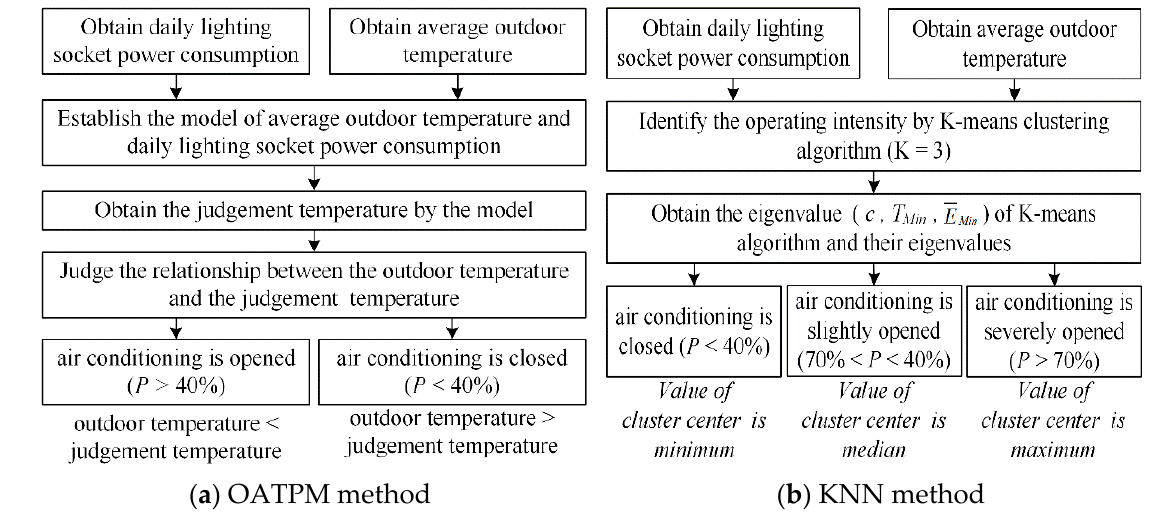
Figure 12. Identification method of air-conditioning usage condition on the designated day.